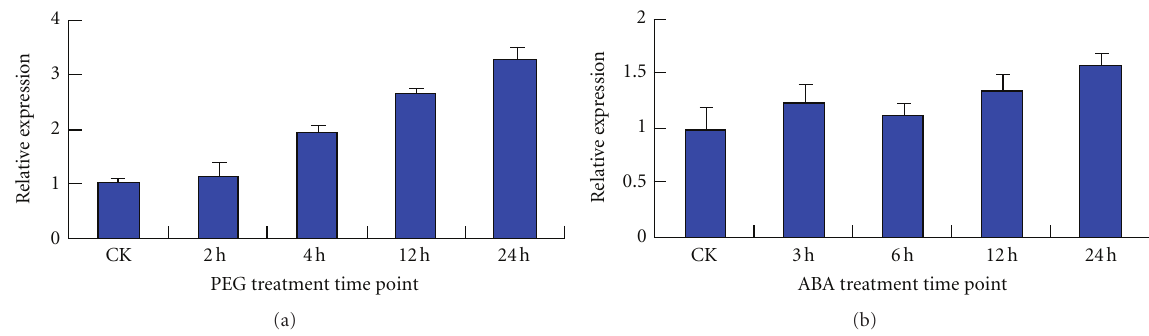
Figure 4: Expression profiling of ammonia monooxygenase gene (EU071781) in E. arundinaceum under PEG (a) and ABA (b)